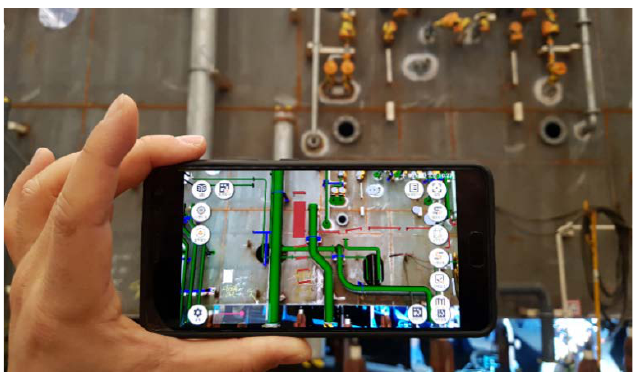
Figure 1. Installation inspection using proposed augmented reality (AR) system.